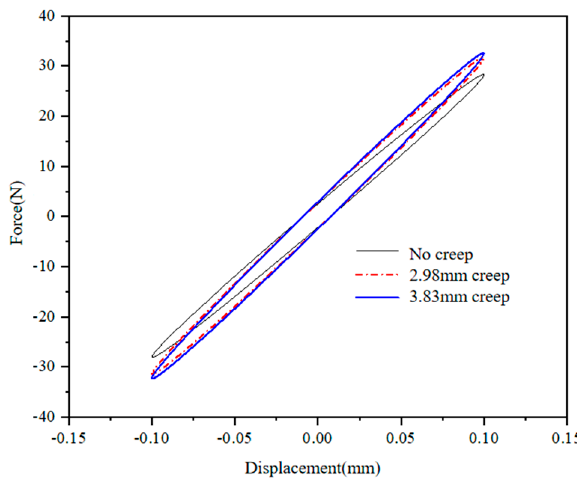
Figure 15. Suspension force-displacement hysteresis loop of different creep.